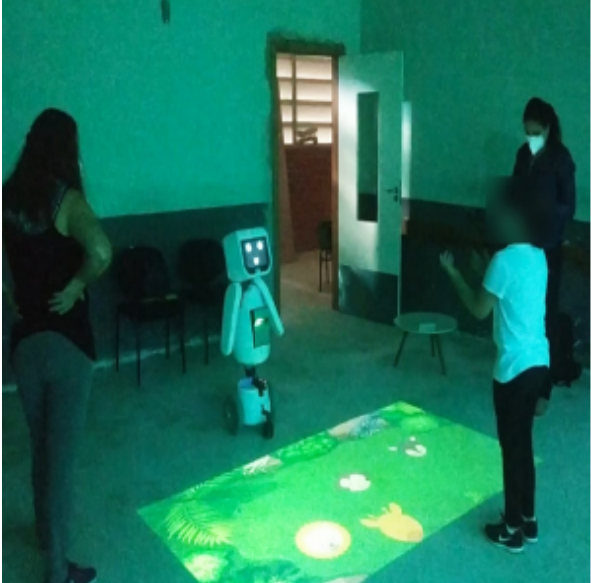
Figure 13. Girl interacting with the robot during the game “Animal